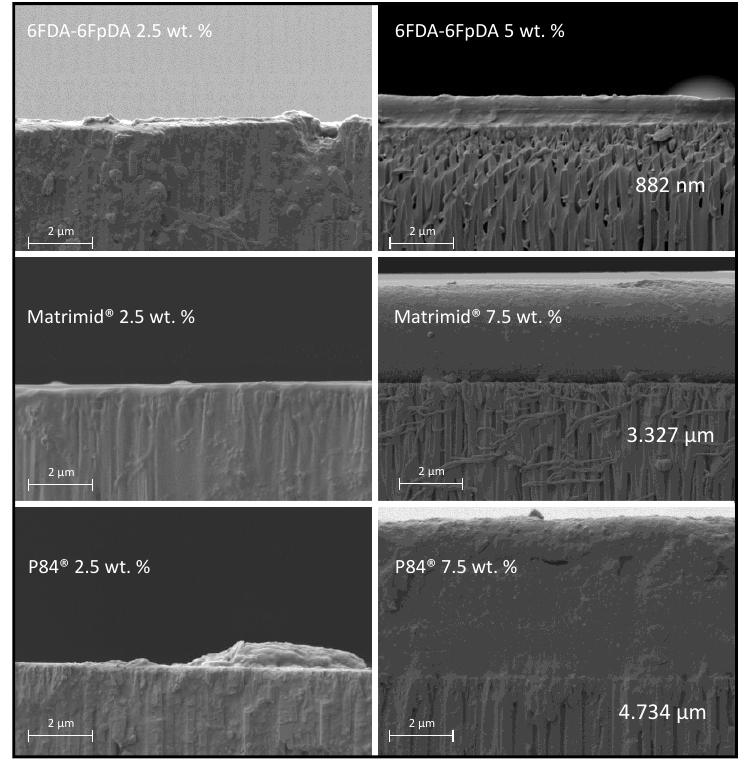
Figure 9. Cross-section SEM micrographs for the polymers deposited with two different solution concentrations: C < C * (2.5 wt. %) and C > C * (5 wt. % for the 6FDA-6FpDA and 7.5 wt. % for P84 ® and Matrimid ® ).